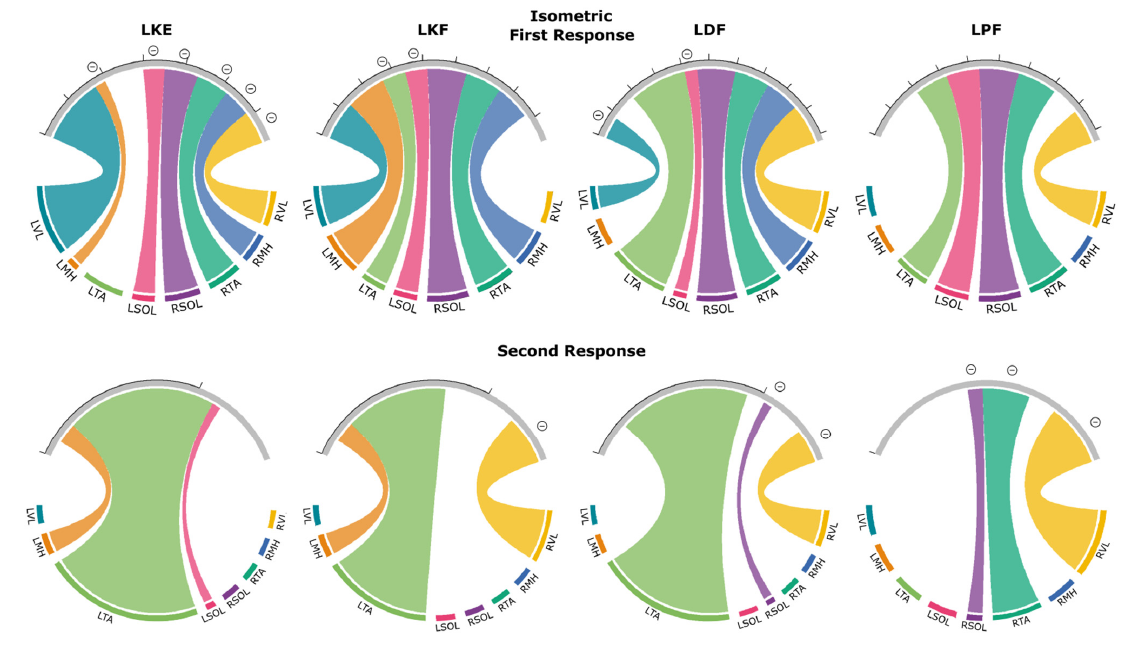
Figure 7. Excitability and inhibitory interactions during left knee extension (LKE), left knee flexion (LKF), left dorsiflexion (LDF) and left plantarflexion (LPF) isometric contraction: averaged significant ( p < 0.05) facilitations or inhibitions during first ( top ) or second ( bottom ) responses during tactile cues. Each first response is scaled to the control condition where control is 100% and corresponds to the distance between tick marks. Second responses are given as the ratio between second and first response for that pair of responses. Individual muscles are grouped along the bottom of each plot. Thickness of connections denotes the amount of inhibition or facilitation found where significant inhibition is designated with a circled minus sign.